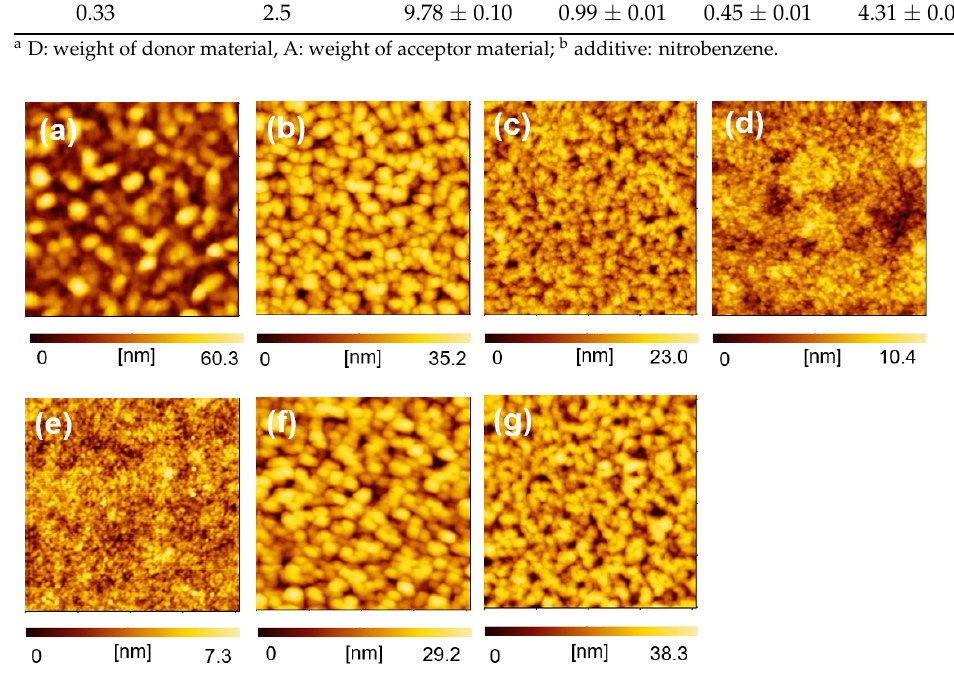
Figure 6. AFM images of BHJ films composed of PTB7:EH-IDTBR after BGE washing (2 µ m × 2 µ m). D/(D + A) ratios of PTB7:EH-IDTBR are as follows: ( a ) 0.20, ( b ) 0.33, ( c ) 0.40, ( d ) 0.50, ( e ) 0.60, ( f ) 0.33 with 1 vol% nitrobenzene, and ( g ) 0.33 with 2.5 vol% nitrobenzene.